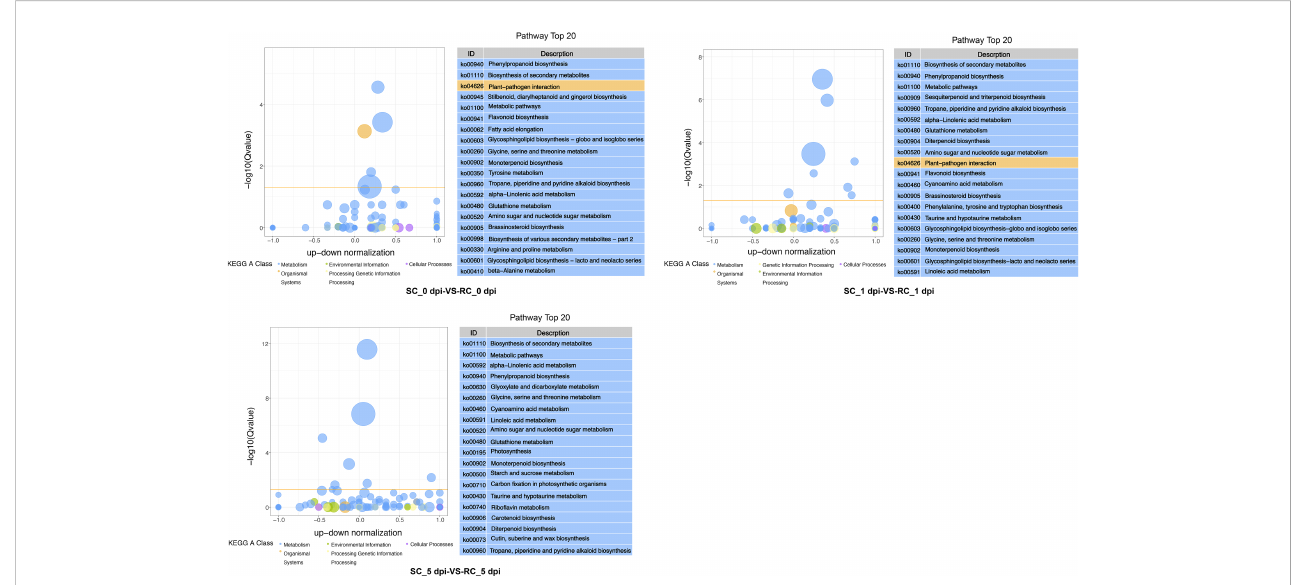
FIGURE 4 KEGG pathway analysis of pairwise comparisons (SC vs. RC) at 0, 1, and 5 dpi; the chart shows the top 20 pathways enriched in the selected group. The yellow line represents the threshold of Qvalue=0.05, and different colors represent different KEGG A class.